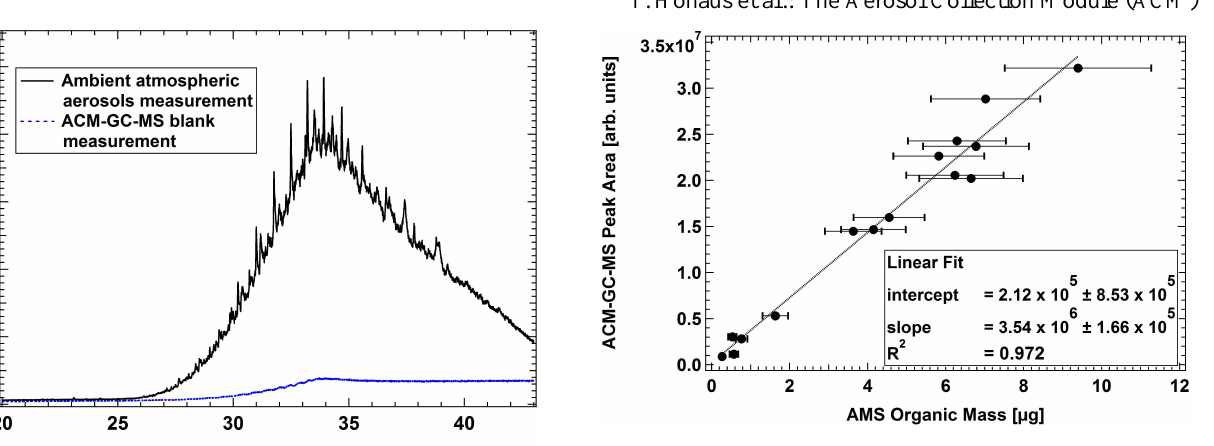
Fig. 9. Comparison of the signal measured with the ACM GC-MS to organic mass measured with a co-located